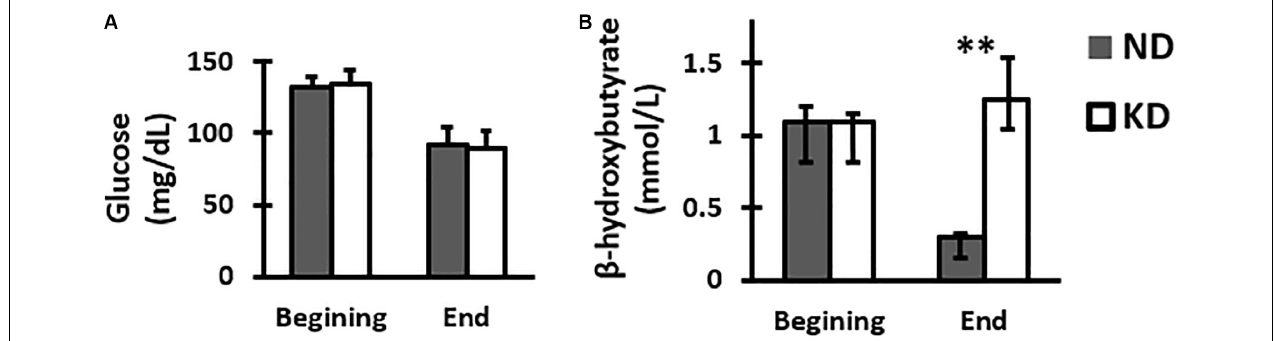
FIGURE 1 | Graph of the mean and SD of glucose (A) and median with IQR of β -hydroxybutyrate (B) concentrations in peripheral blood of group feed with normal diet (ND) or ketogenic diet (KD) at the beginning and end of treatment, n = 8 in each group. There were no significant differences between the two groups at beginning and end in the glucose levels. However, there was a significant increase in the β -hydroxybutyrate KD group when compared with ND group at the end of treatment ( ∗∗ p < 0.01, Mann-Whitney U -test).